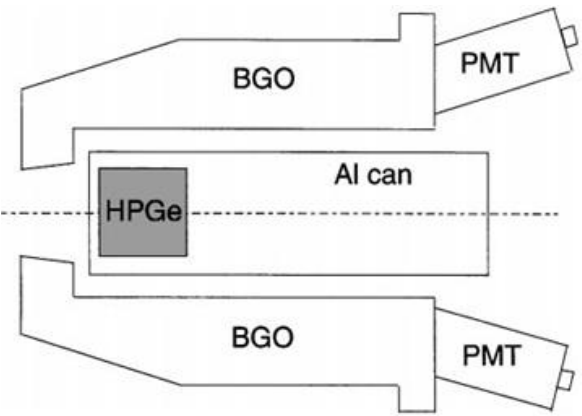
Figure 8. Compton suppression system manufactured by California University [36].